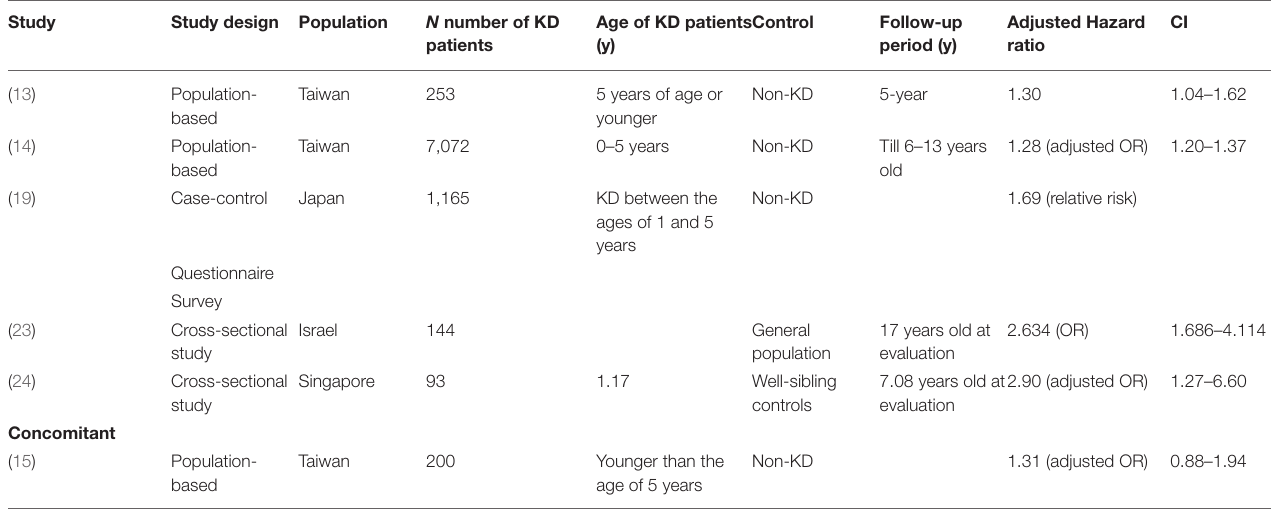
TABLE 2 | Effect of Kawasaki disease on allergic